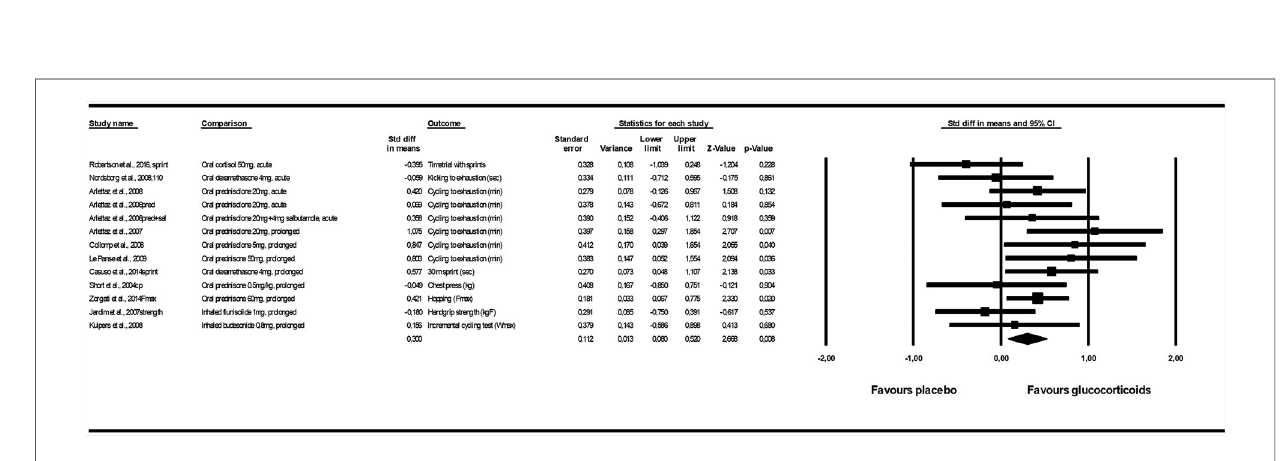
FIGURE 3 Forest plot fot the effect of glucocorticoids on maximal